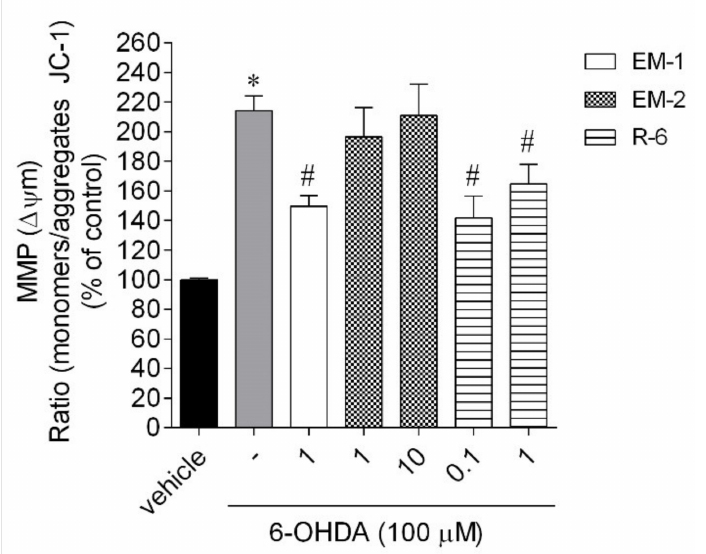
Figure 8. Changes in mitochondrial membrane potential (MMP) of SH-SY5Y cells following treatment with 6-OHDA (100 µ M) in the presence/absence of peptides (0.1–10 µ M, 6 h). The values in each column represent the mean ± standard error of the mean (SEM) of 3 or 4 independent experiments. Symbols represent significant differences (ANOVA, Dunnett’s test, p < 0.05) when compared to: * vehicle and # 6-OHDA. (-)